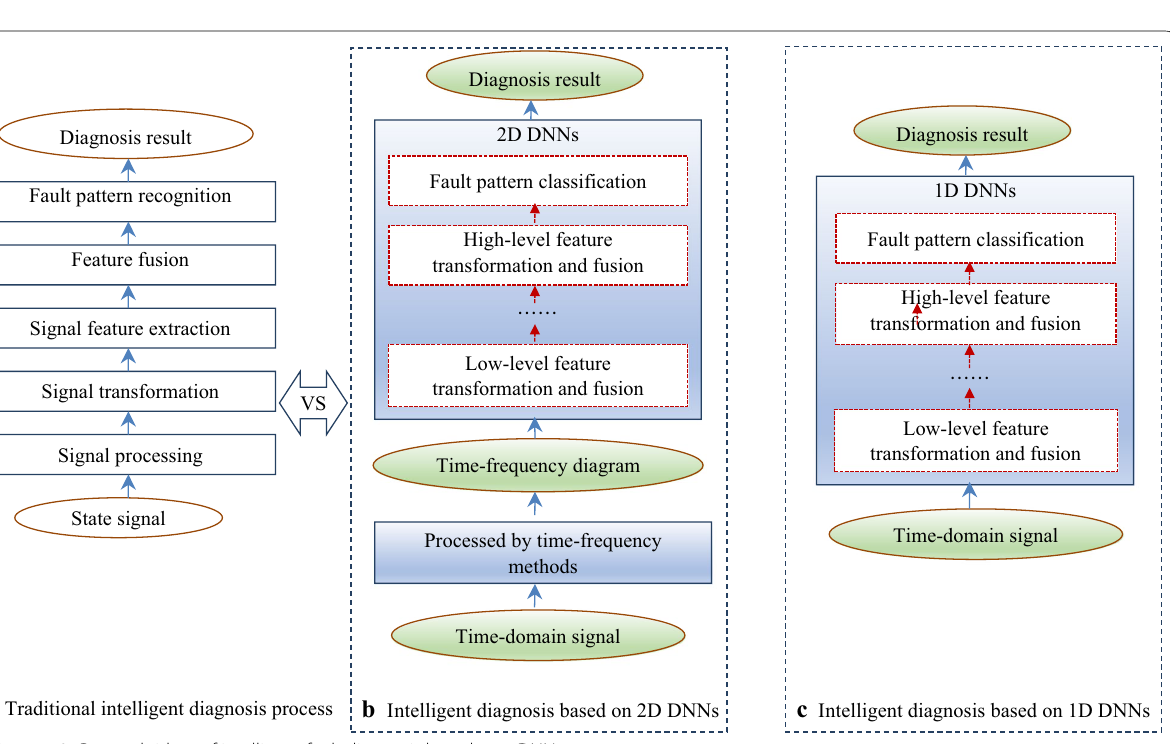
Figure 12 Research ideas of intelligent fault diagnosis based on a